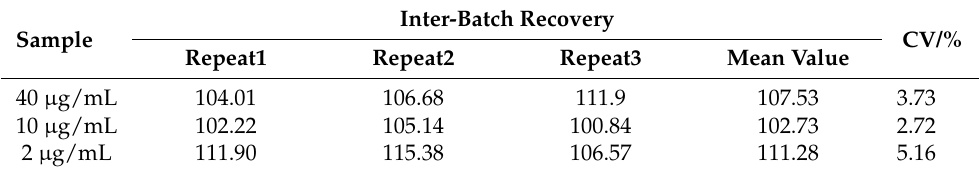
Table 2. The intra-assay coefficients of variability.